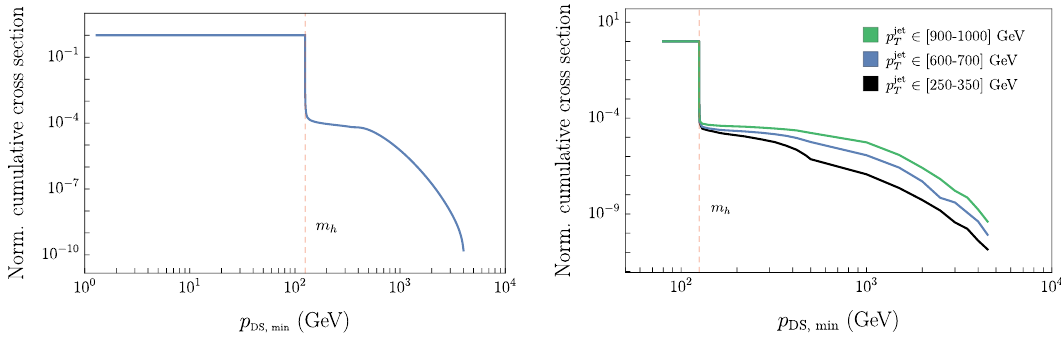
JHEP06(2021)127